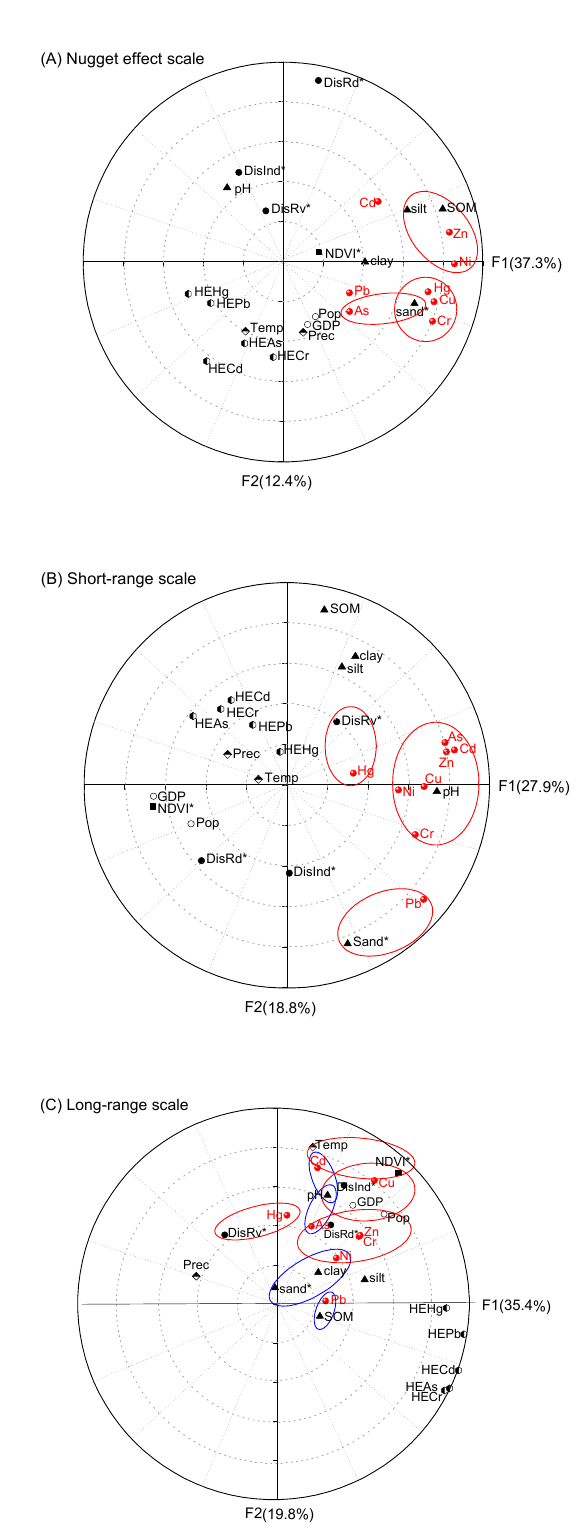
Figure 3. Projections of the correlations between the spatial components for the heavy metals and the principal component scores into unit circles at the nugget ( A ), short-range ( B ), and long-range ( C ) scales. The variables within circles in red or blue indicate close correlations amongst each